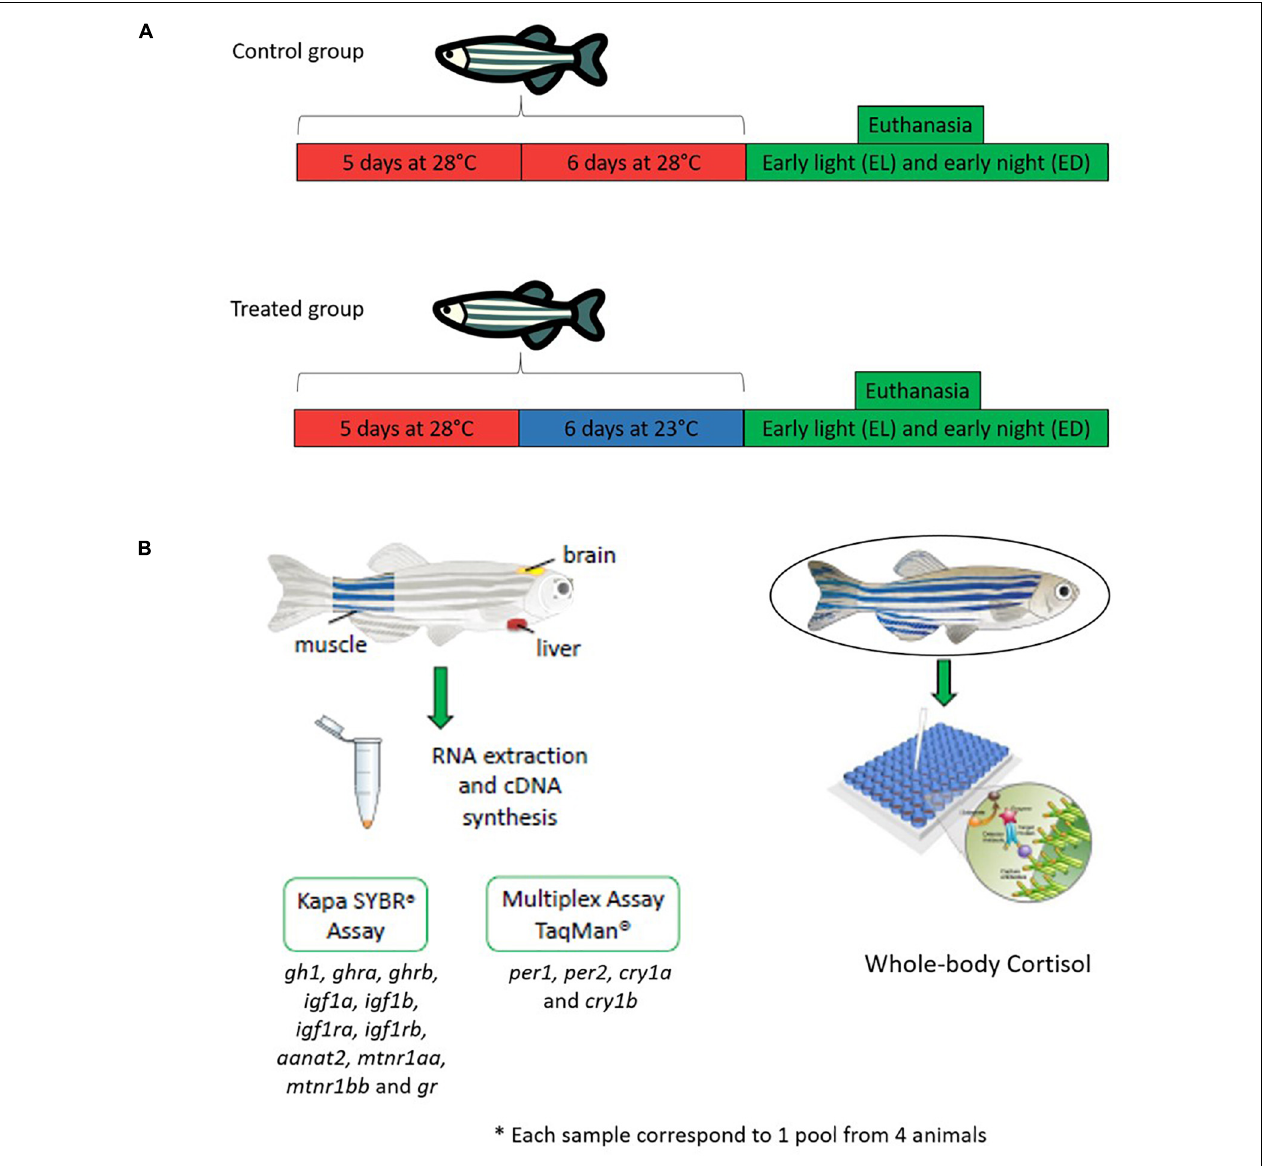
FIGURE 1 | Experimental design. (A) Danio rerio male adults ( n = 144) were divided in two large groups: a control temperature group (animals maintained at 28 o C during 5 days and challenged 6 days at the same temperature) and a lower temperature group (animals maintained at 28 o C during 5 days and challenged 6 days at lower temperature 23 o C). After stimulation the animals were euthanized at early light (EL, 10 AM) and early dark (ED, 12 AM). (B) For the analysis, fish were separated into another two groups: a qPCR (96 animals) and a cortisol (48 animals) group. For the qPCR we evaluated gh1, aanat2, mtnr1aa, mtnr1bb, opn4m1, opn4m2 in the brain, ghra, ghrb, igf1a, igf1b, igf1ra, igf1rb, gr in the liver and muscle. Also, in all tissues analyzed we performed a qPCR for clock genes ( per and cry). Each experimental n comprised pooled tissues from four fish. The total number of samples used in each temperature and time point was n = 3–6.